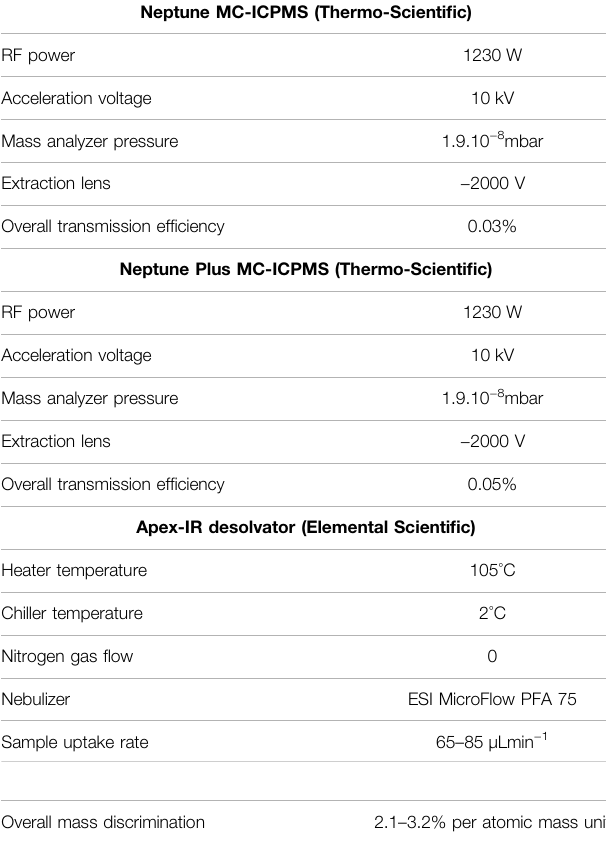
TABLE 1 | MC-ICPMS and desolvator operation parameters.